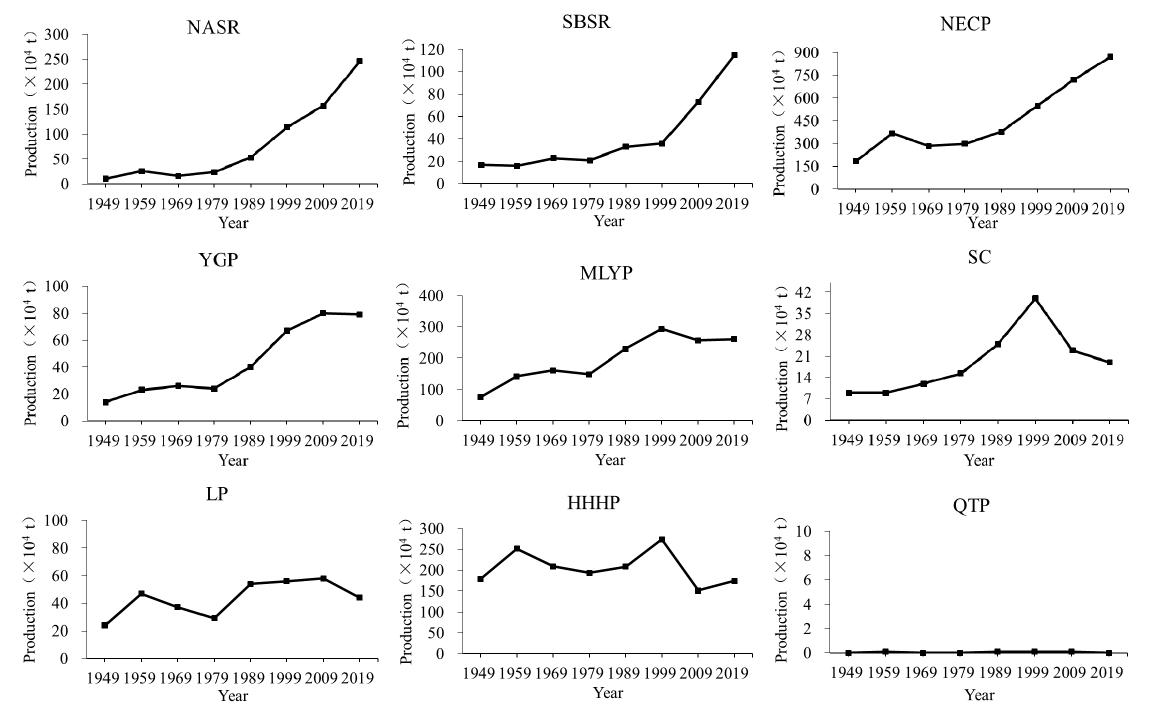
Figure 3. Changes in soybean production in the nine agricultural zones of China from 1949 to 2019.